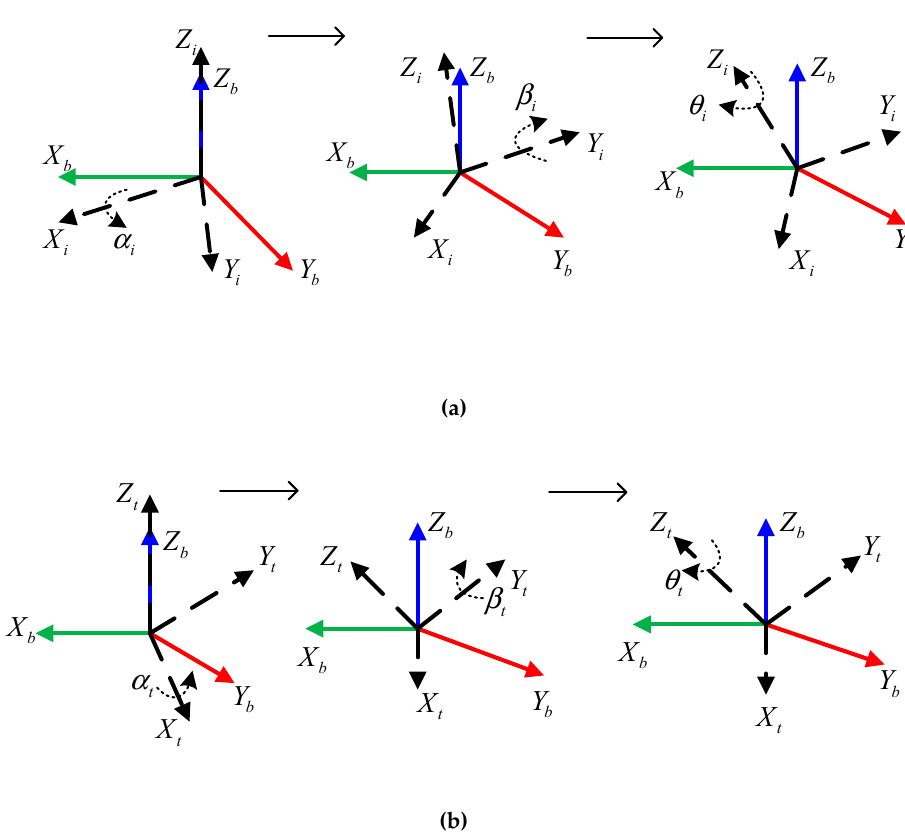
Figure 7. Rotation transformation of ( a ) inertial data and ( b ) vision data.